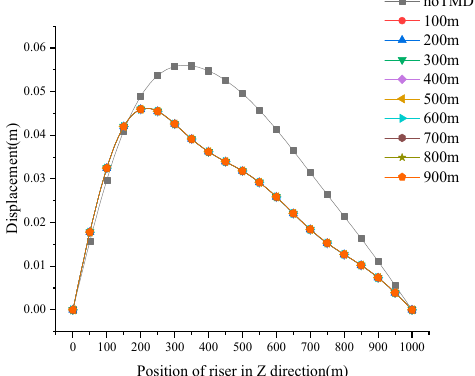
Figure 4. RMS of the vibration displacement of the riser in the in-line direction when the TMD is installed at different positions.